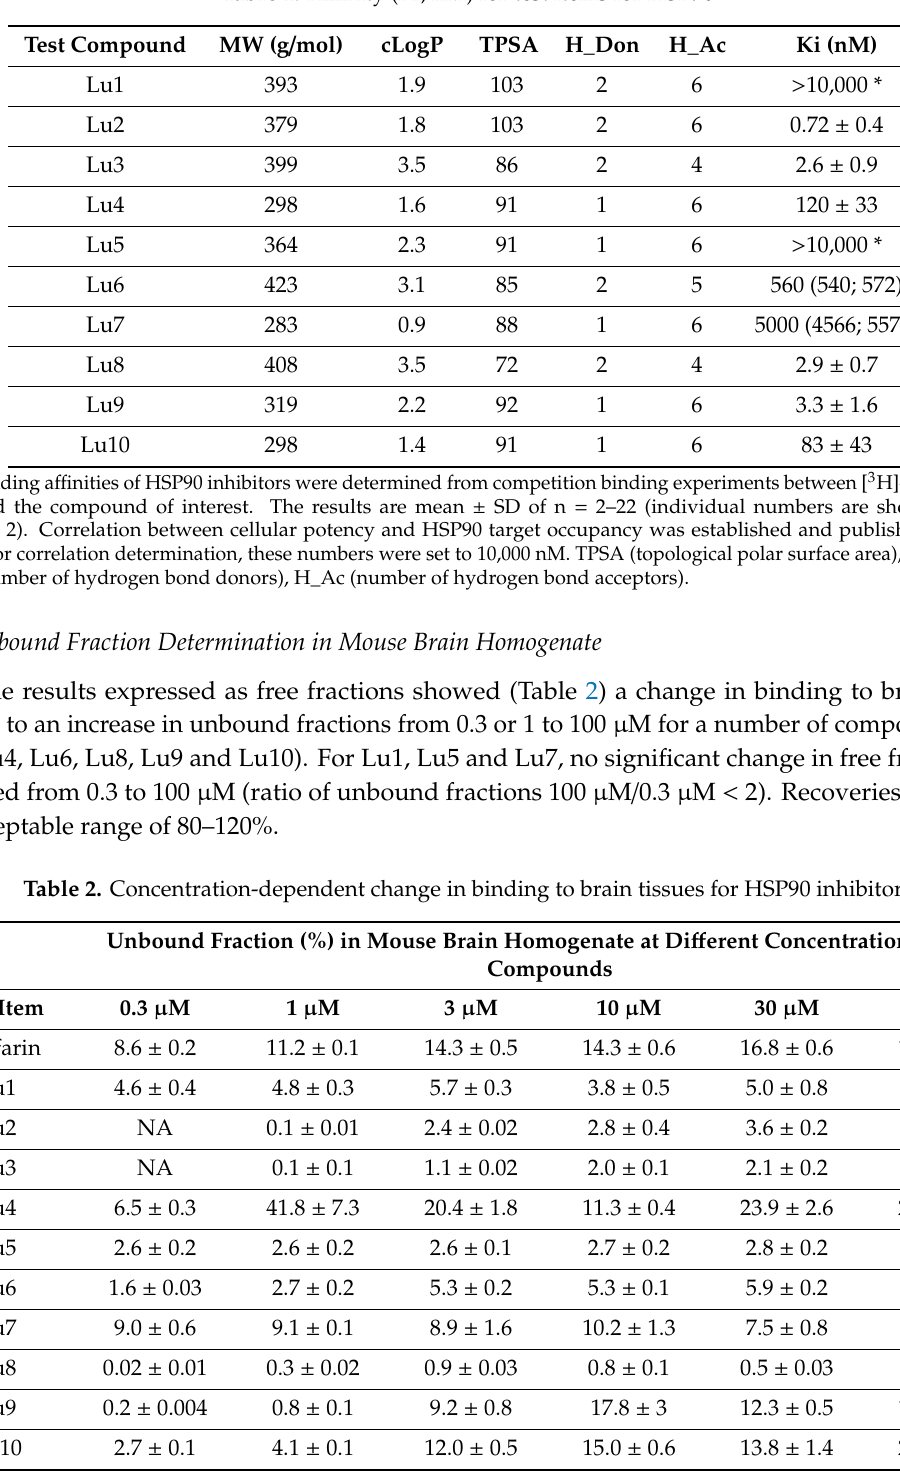
Table 1. A ffi nity (Ki, nM) for test items for HSP90.